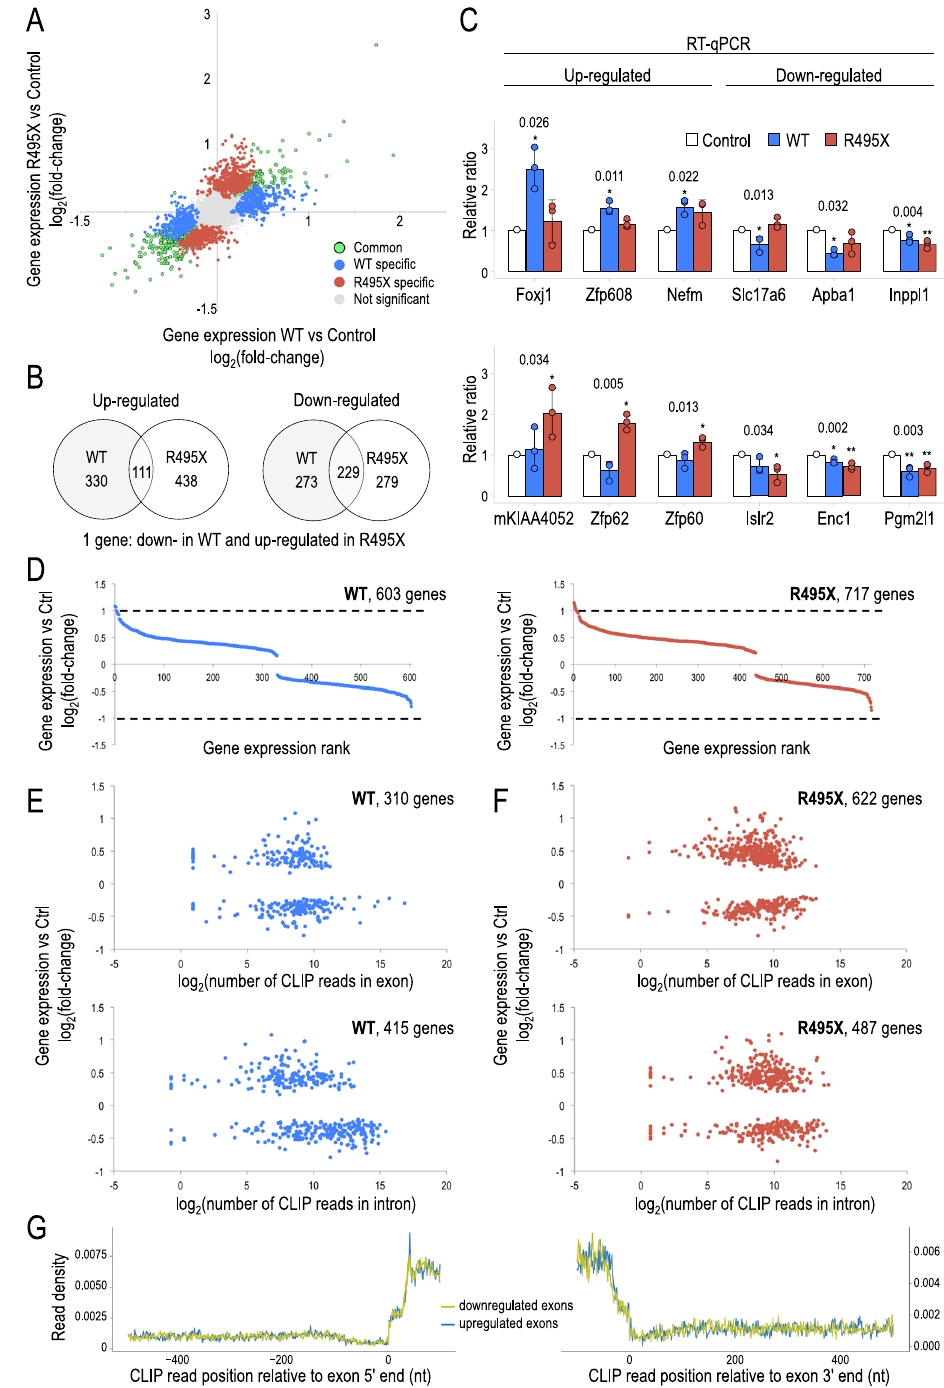
Figure 3. Differential gene expression analysis for WT- and R495X-expressing neurons. ( A ) Scatter plot of WT versus control and R495X versus control differential gene expression. Differential gene expression is quantified as log 2 (fold-change). ( B ) Venn diagram showing the number of up- (left) and down- (right) regulated genes in WT- and R495X-expressing neurons. ( C ) Bar plots of expression measured by RT-qPCR for up- (left) and down- (right) regulated genes that are differentially expressed in WT- (top) or R495X-expressing neurons (bottom). Values indicate P-values of one-way ANOVA test. * p < 0.05, ** p < 0.01, post Tukey’s HSD test. Error bar indicates standard deviation (N = 3). ( D ) Gene differential expression for ranked list of differentially expressed genes for WT- (left) and R495X-expressing neurons (right). Dashed lines indicate 2-fold difference. ( E , F ) Scatter plot of gene differential expression versus FUS binding levels for WT ( E ) and R495X ( F ). FUS binding is quantified in exons (top) and introns (bottom). ( G ) R495X CLIP binding density upstream (left) and downstream (right) of up- and down-regulated exons. Position 0 corresponds to the 5 ′ end (left) and 3 ′ end (right) of